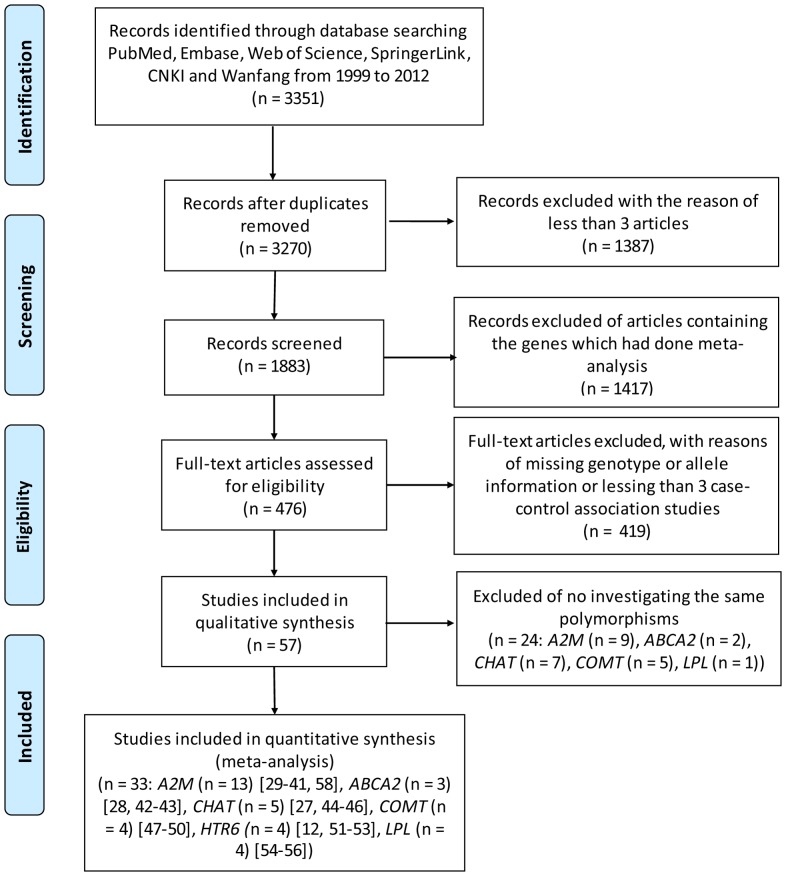
Flow diagram of the 8 meta-analyses.